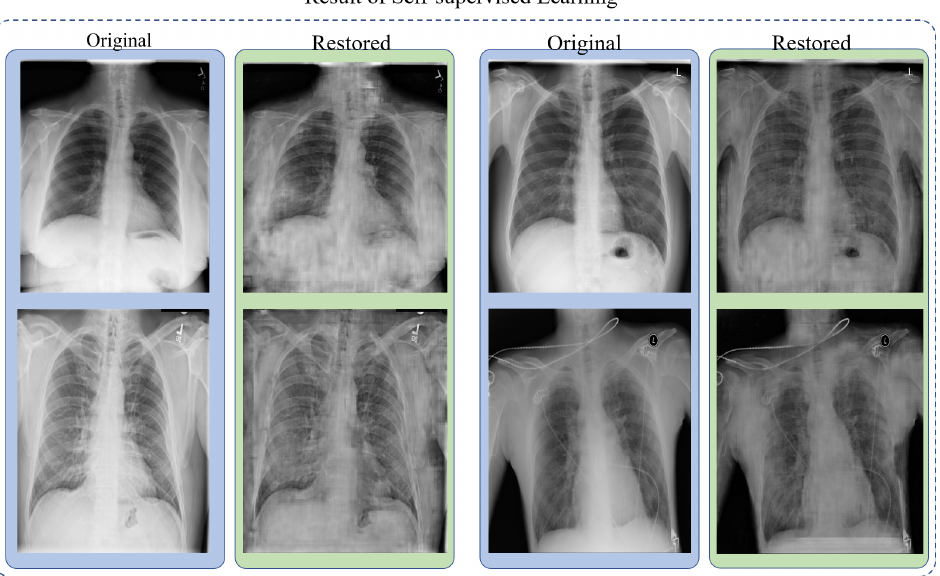
Figure 6. Result of self-supervised